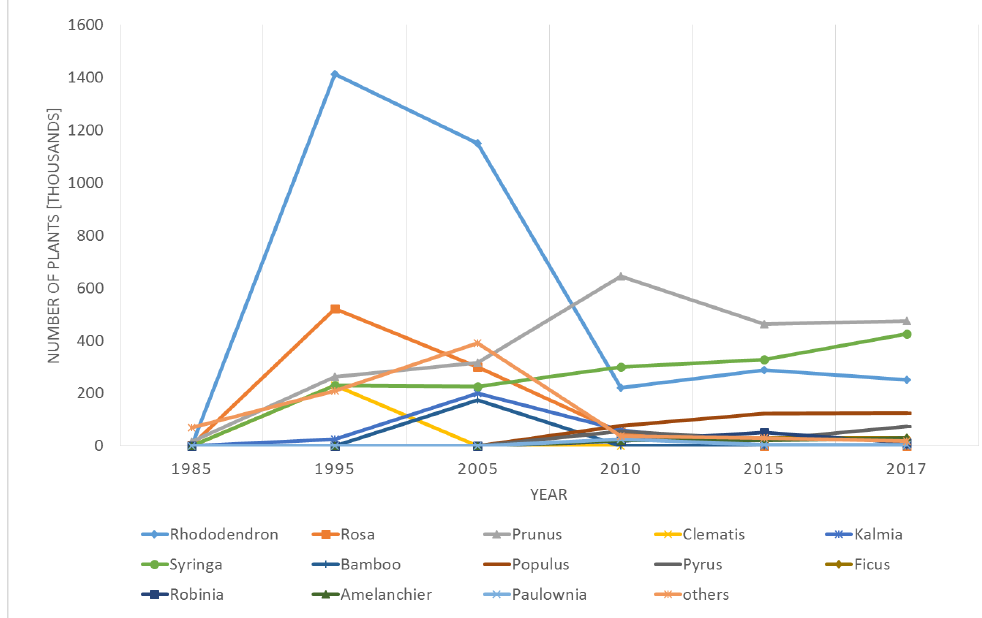
Fig. 5: Plant production numbers of tree species and shrubs from 1985 to 2017 (stated by ADIVK members, voluntary